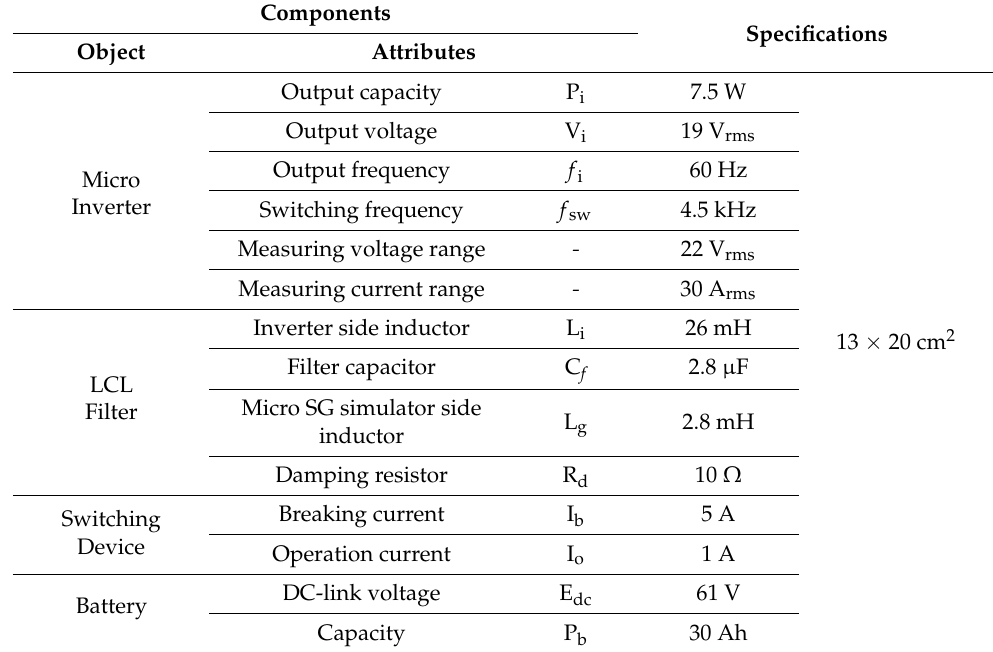
Table 1. Specifications of the micro DG.